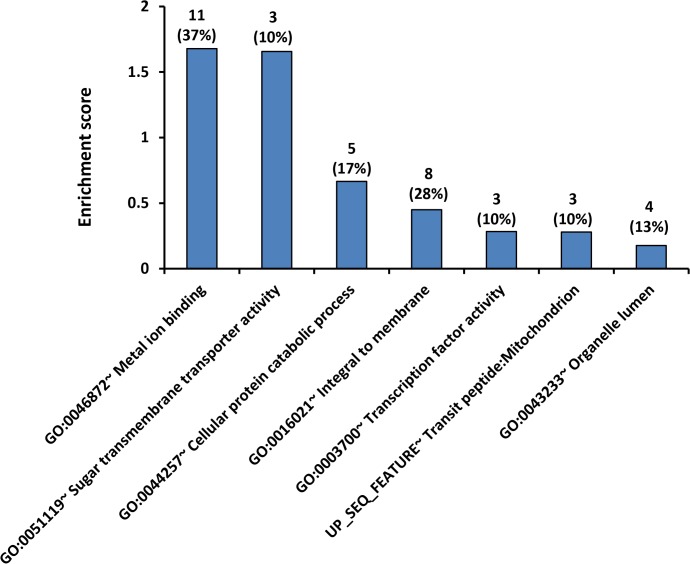
Pathway analysis.Histogram shows a summary of DAVID pathway annotation analysis. The 65 genes which were commonly regulated in H99 versus three environmental strains were selected and analyzed. The number of significant genes and their percentages of genes in the database are as indicated.